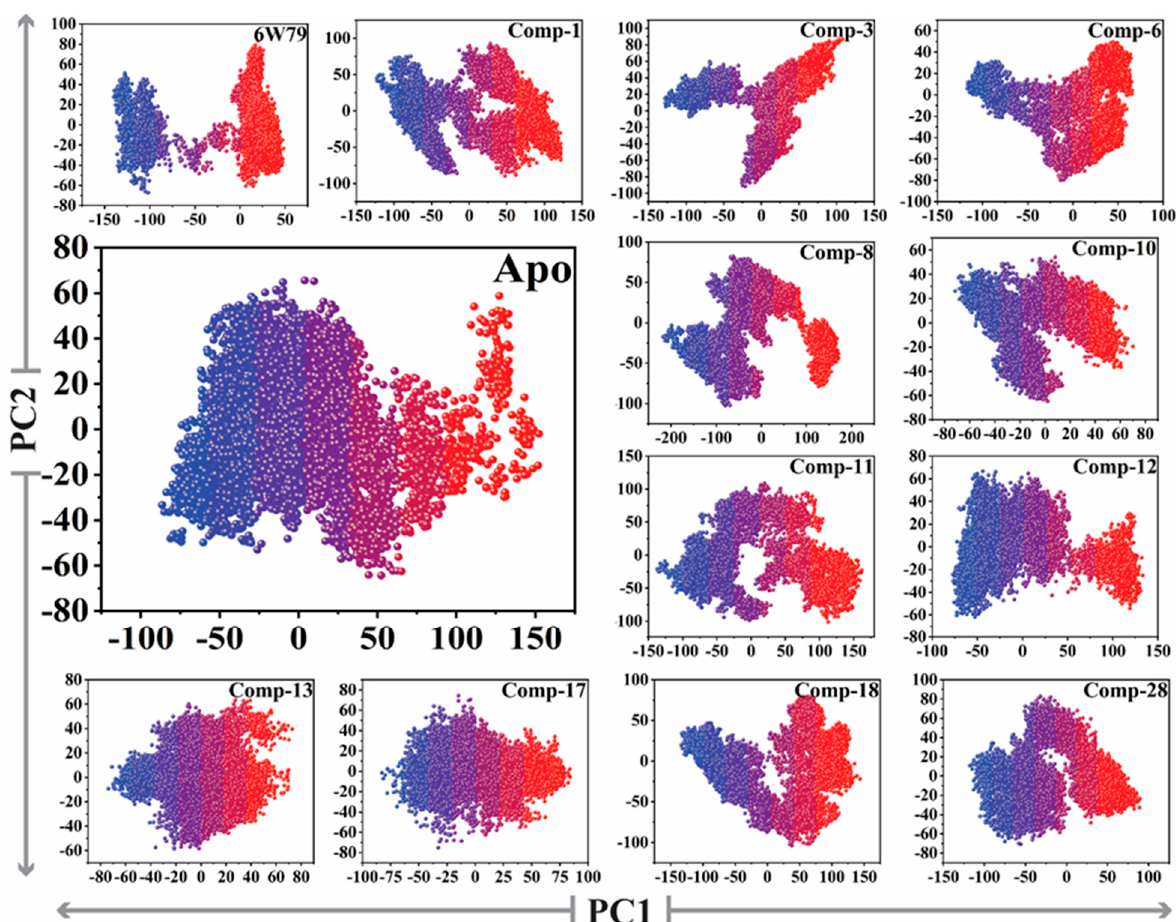
Figure 6. The PCA analysis of apo–M pro and inhibited states of M pro . Principal component 1 (PC1) and principal component 2 (PC2) were plotted against each other using the backbone carbon atoms.